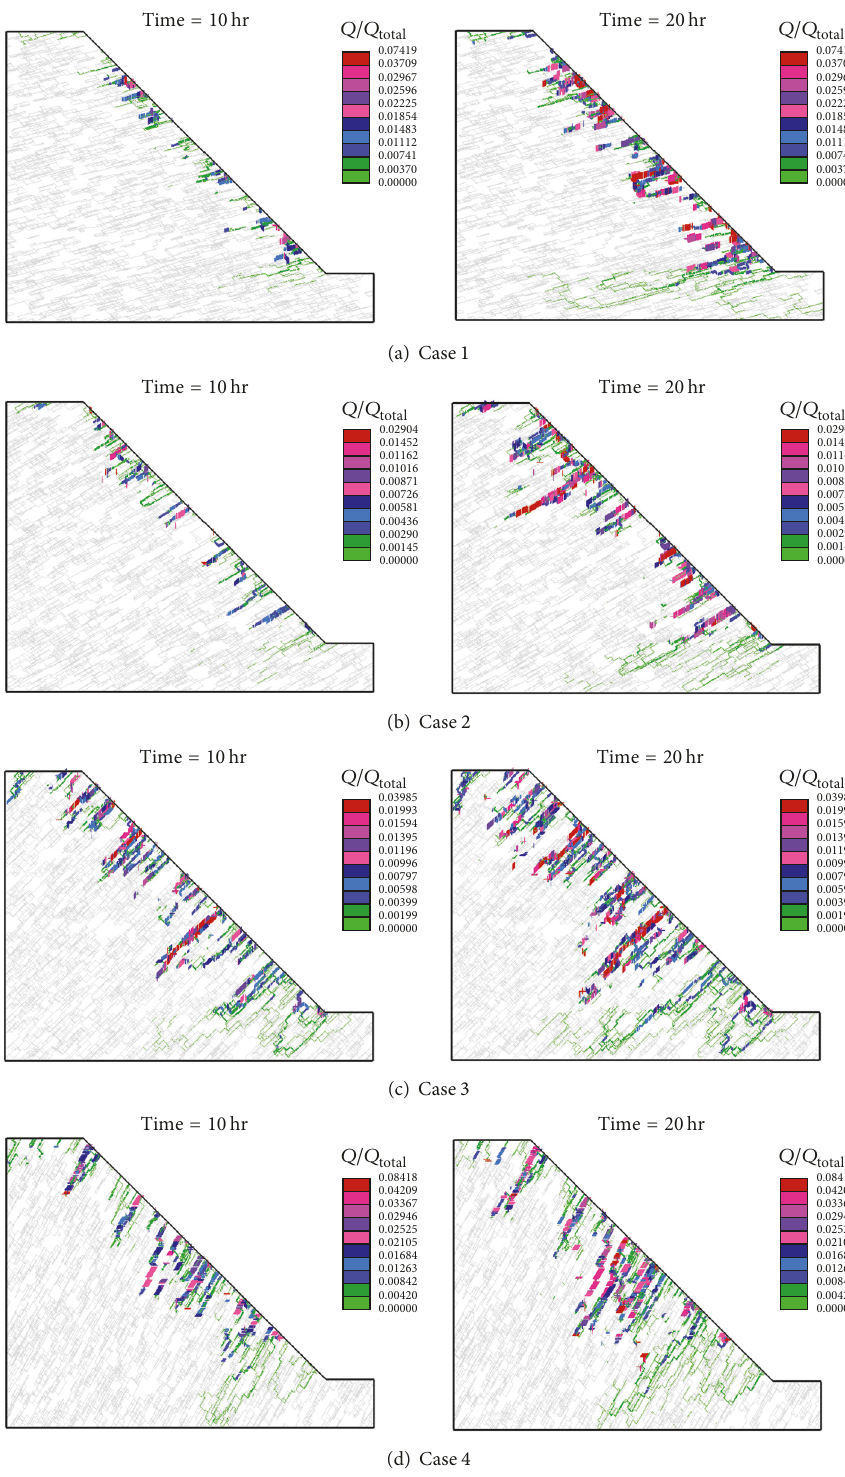
Figure 12: The normalized flow rate distributions in the slope at times (a) 10 hr and (b)